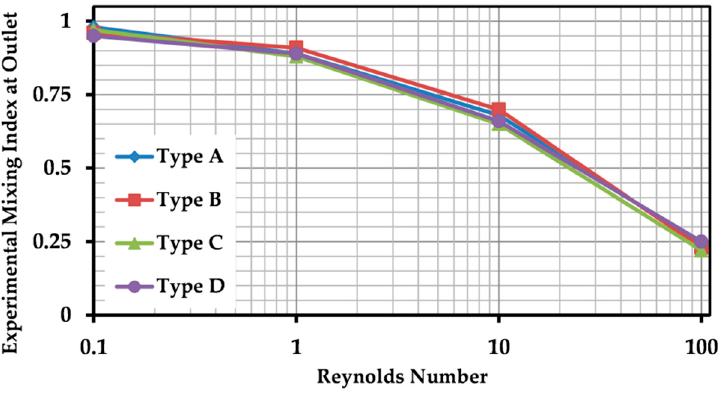
Figure 8. Impact of geometry type of the micromixer (orientation of the sequence of three mixing units) on the mixing performance through MI measurements. Experimental data are presented for a range of Reynolds numbers and four micromixer designs, illustrated in Figure 1.